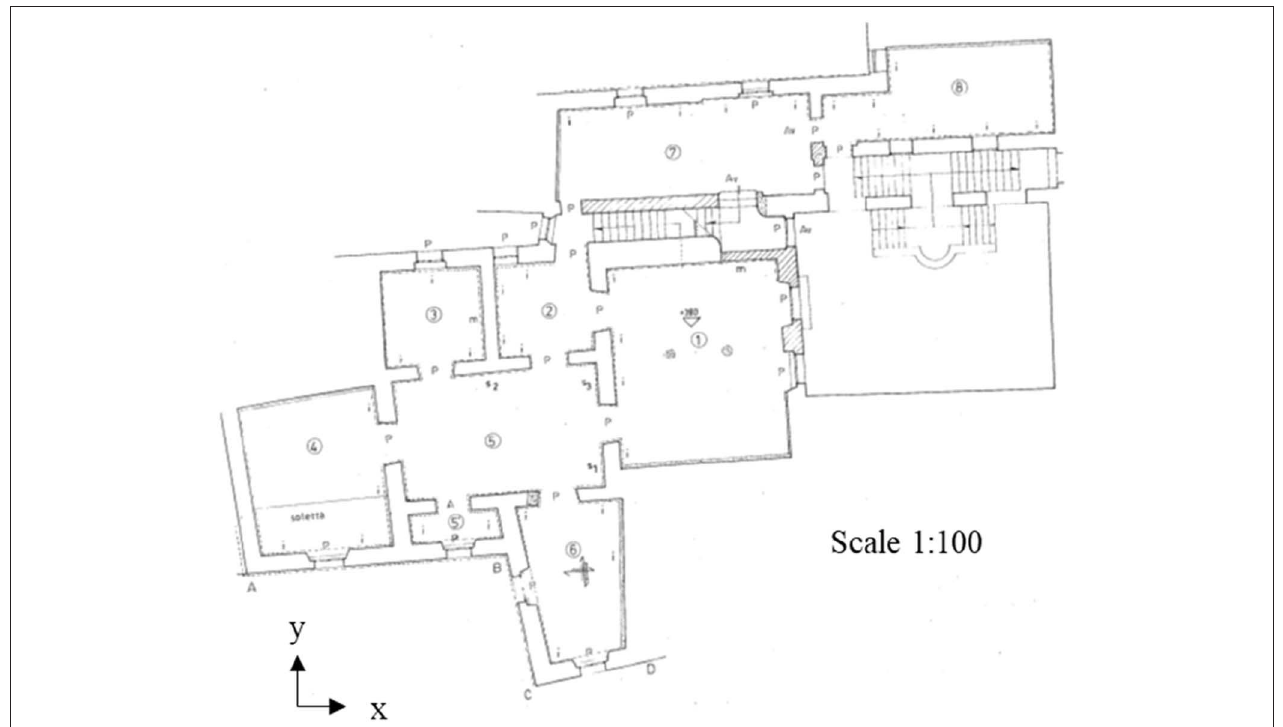
FIGURE 3 | Typical floor view of the